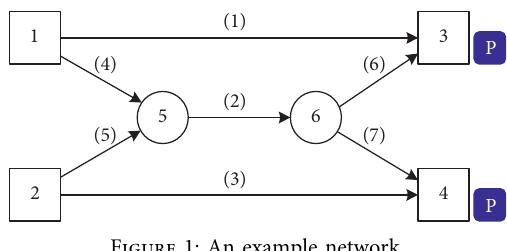
Figure 1: An example network.